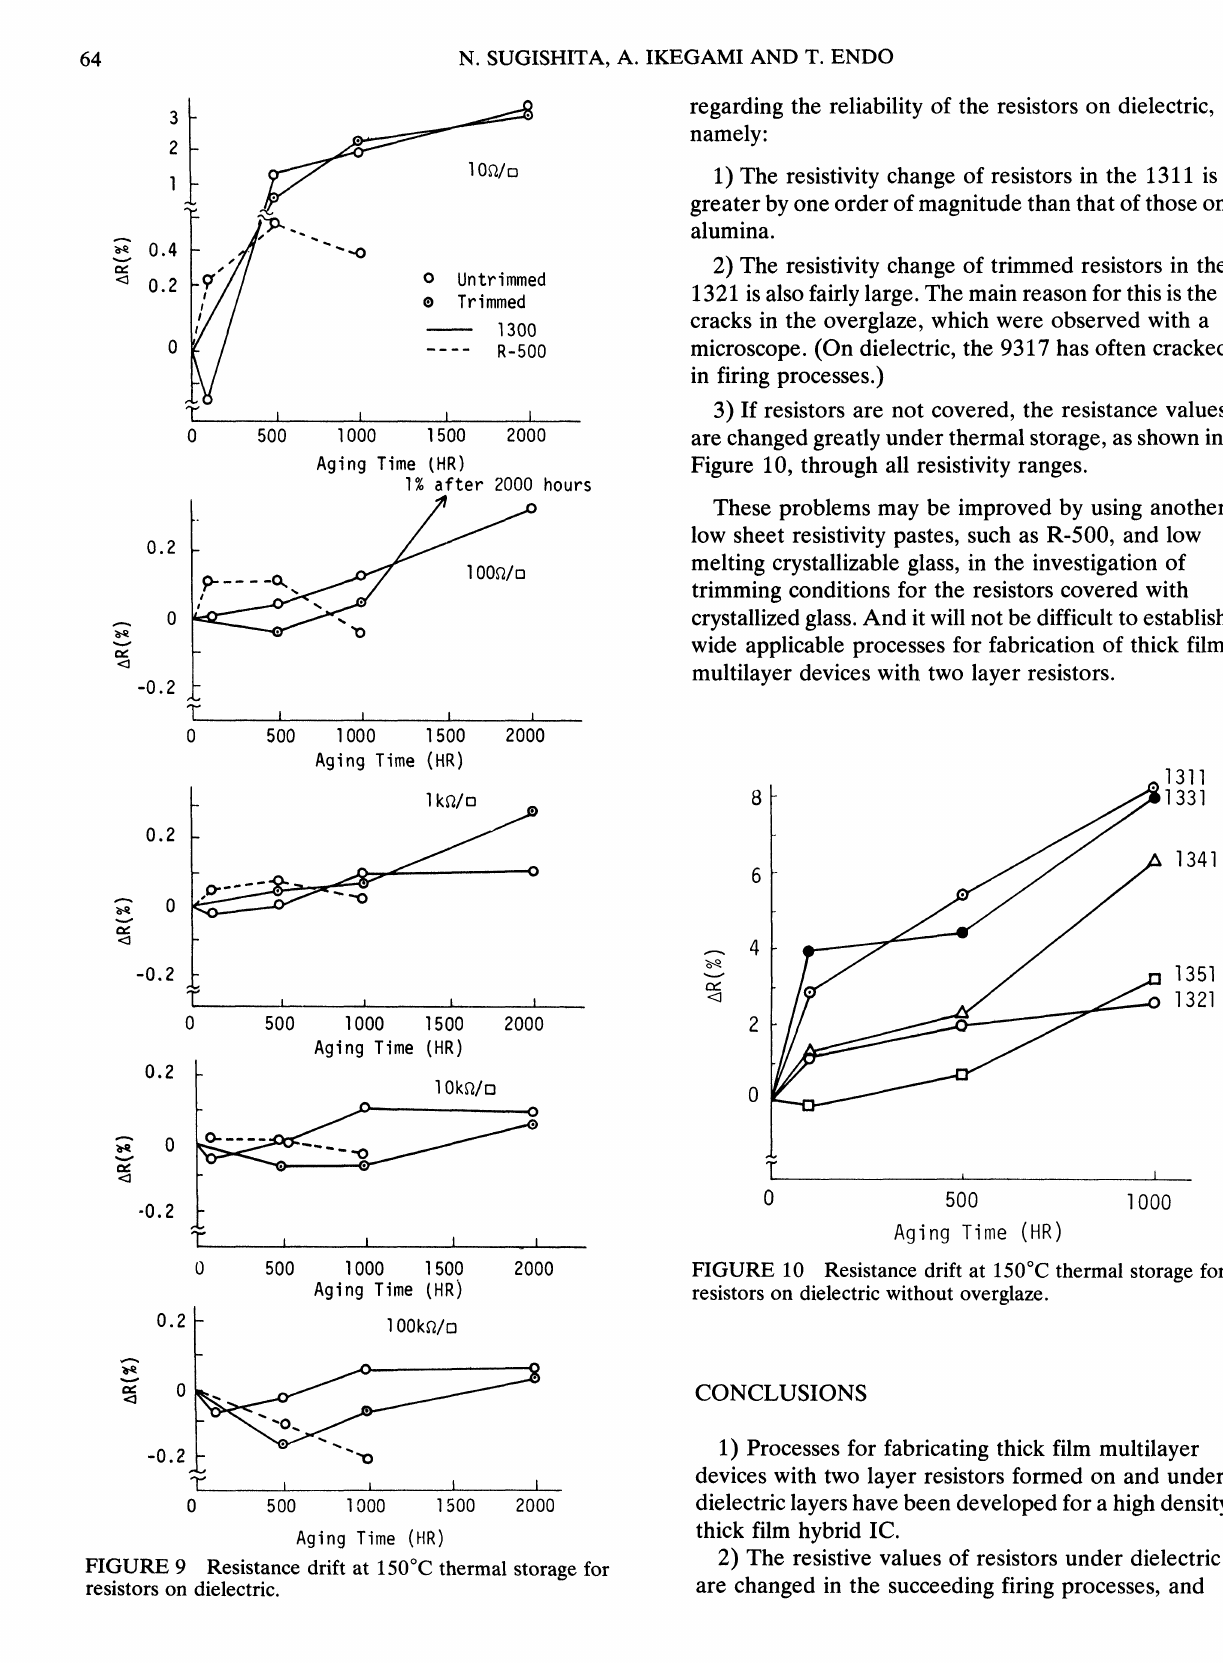
FIGURE 9 Resistance drift at 150C thermal storage for resistors on dielectric.